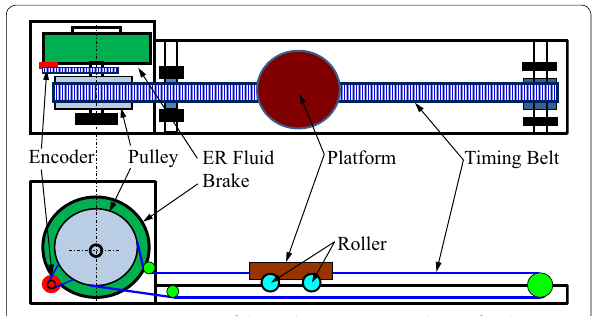
Fig. 5 Schematic image of the isokinetic exercise device for the lower limbs, ERIK